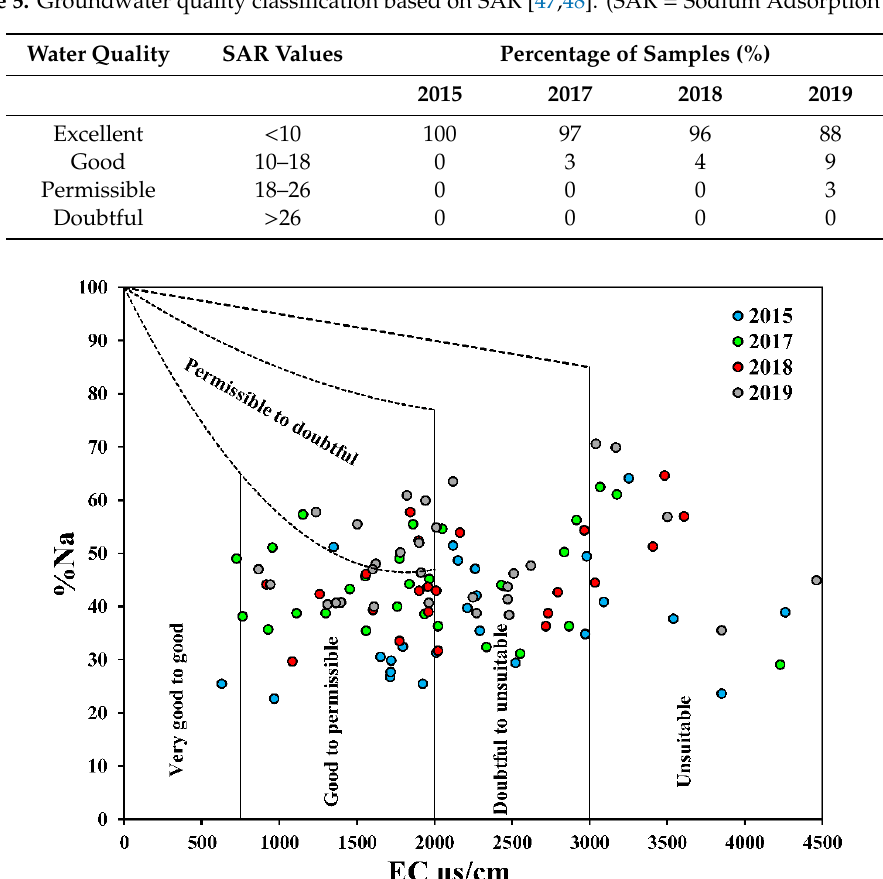
Figure 7. Classification of irrigation water quality based on EC and % Na.